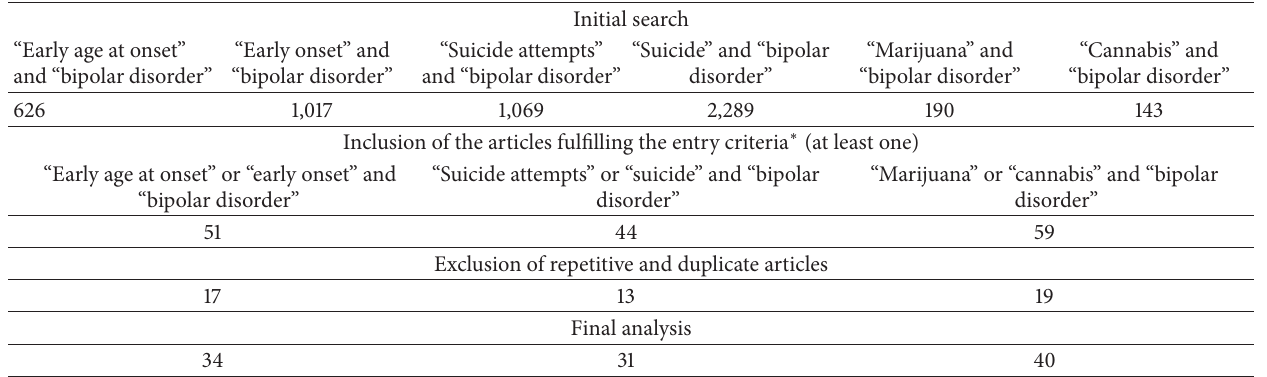
Table 1: Flowchart—selection of articles (see Figure